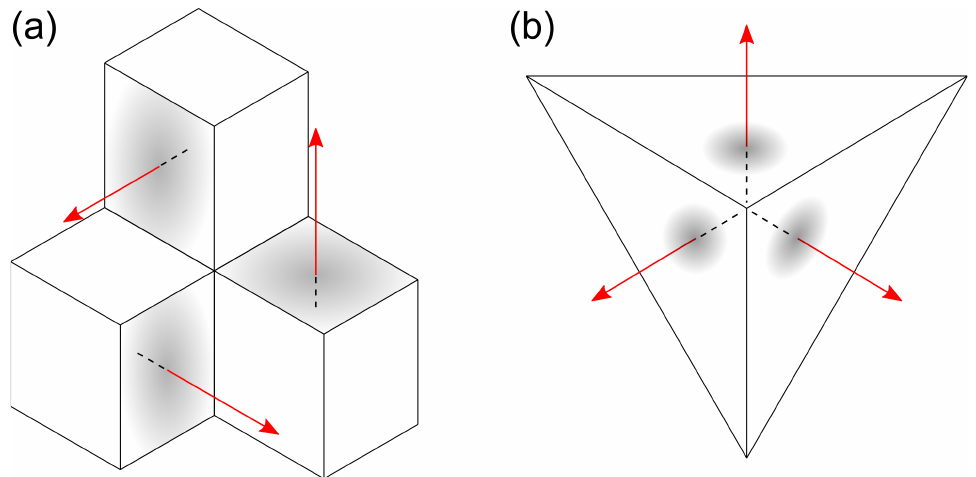
Figure 17. ( a ) Parallelepiped triad versus ( b ) pyramid-shaped triad. It should be noted that the pyramid-shaped triad allows equal wear of each